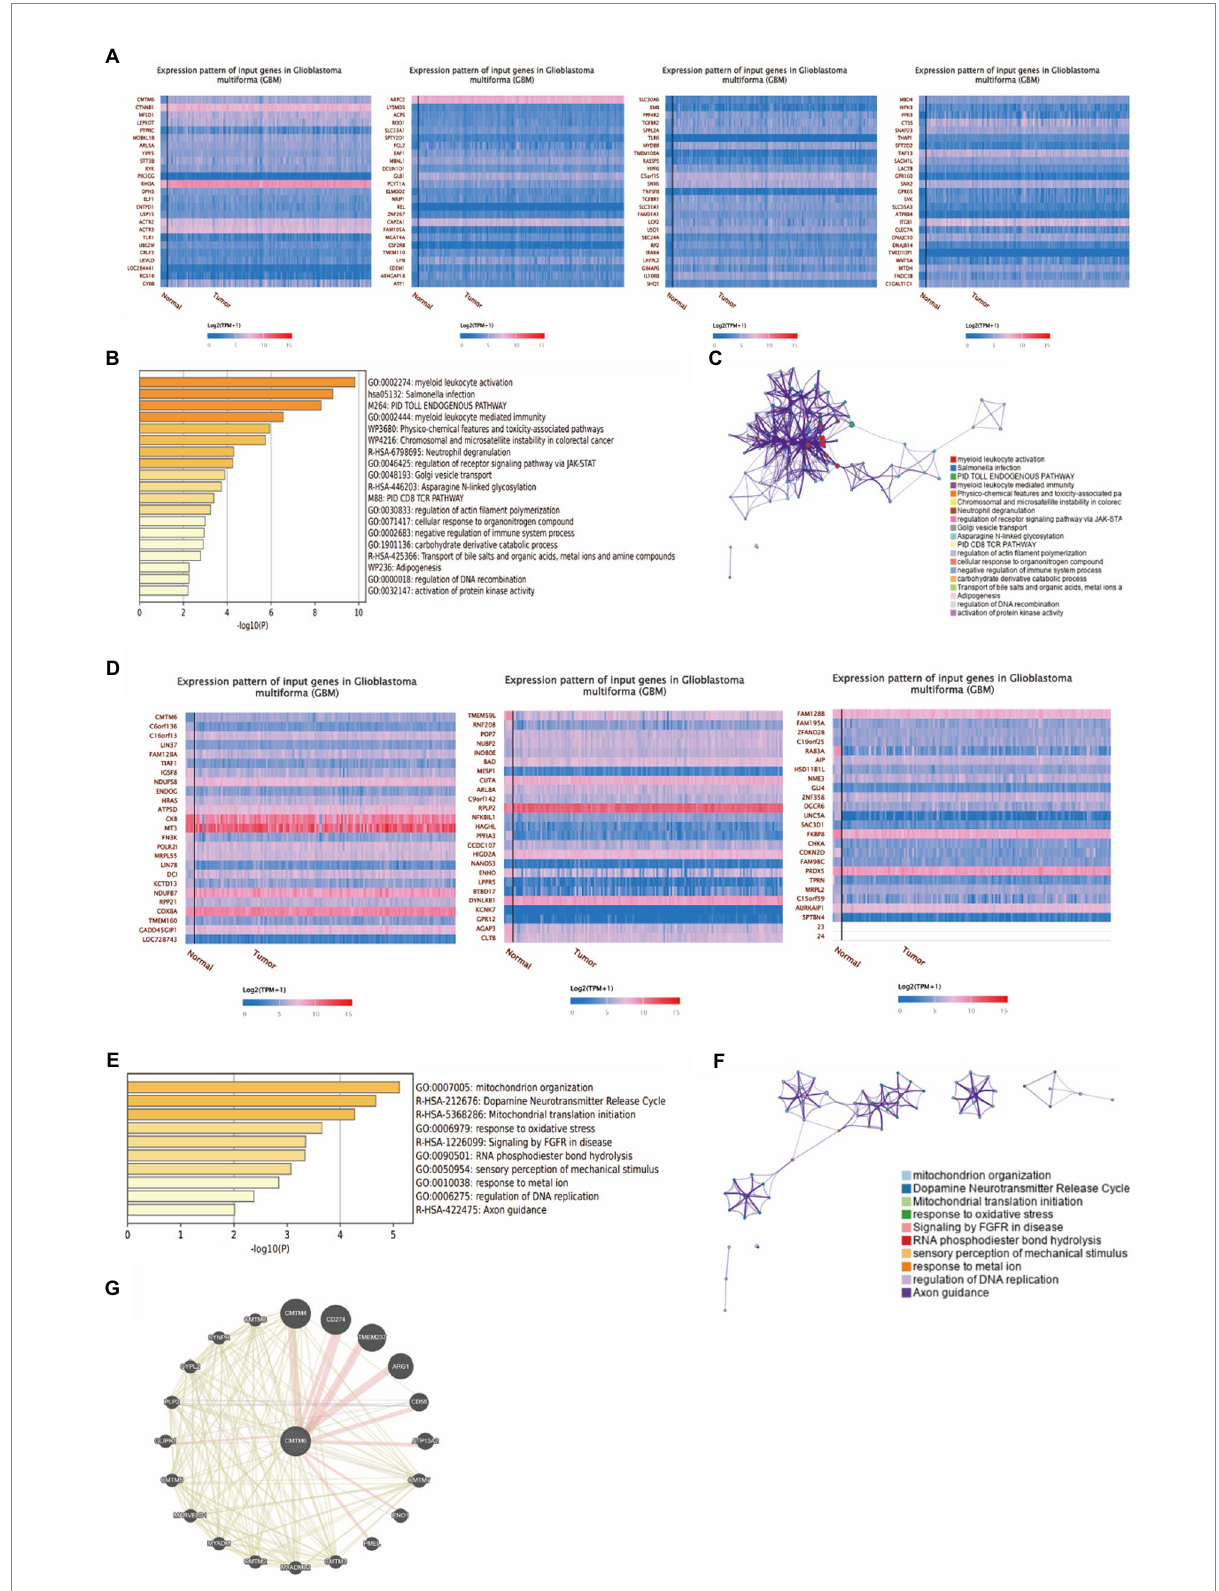
FIGURE 2 Genes associated with CMTM6 in GBM. (A) Heatmap of genes positively associated with CMTM6 in GBM (UALCAN). (B) Bar graph of enrichment of CMTM6 positively associated genes (Metascape). (C) Network map of CMTM6 positively associated genes (Metascape). (D) Heatmap of genes negatively associated with CMTM6 in GBM (UALCAN). (E) Bar graph of enrichment of CMTM6 negatively associated genes (Metascape). (F) Network map of CMTM6 negatively associated genes (Metascape). (G) GeneMANIA analysis of the gene network interacting with